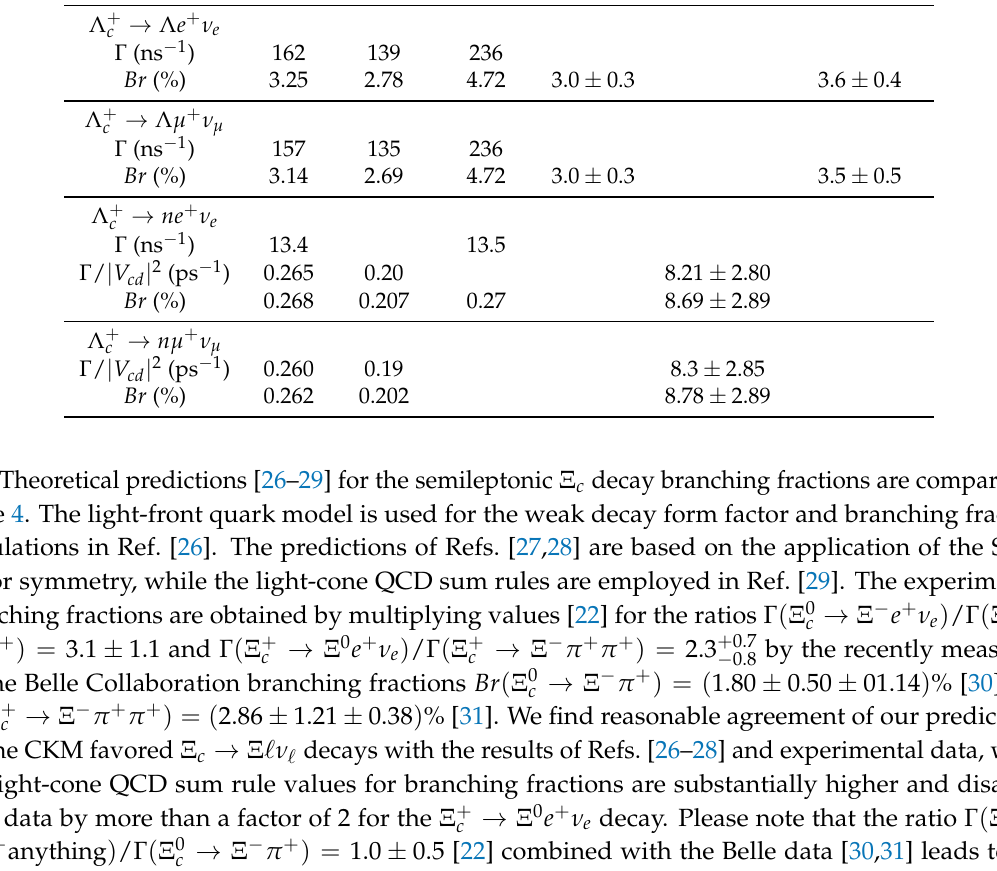
Λ l + ν Λ + + ν Figure 4. Differential decay rates of the Λ + c l ( left ) and l ( right ) c → nl → semileptonic decays. Table 3. Theoretical predictions for the Λ c baryon semileptonic decays and experimental data. Our Ivanov Pervin Liu Azizi Experiment Parameter RQM CCQM SRQM LCSR LCSR PDG [3] [13–15] [16] [24] [25] [22]